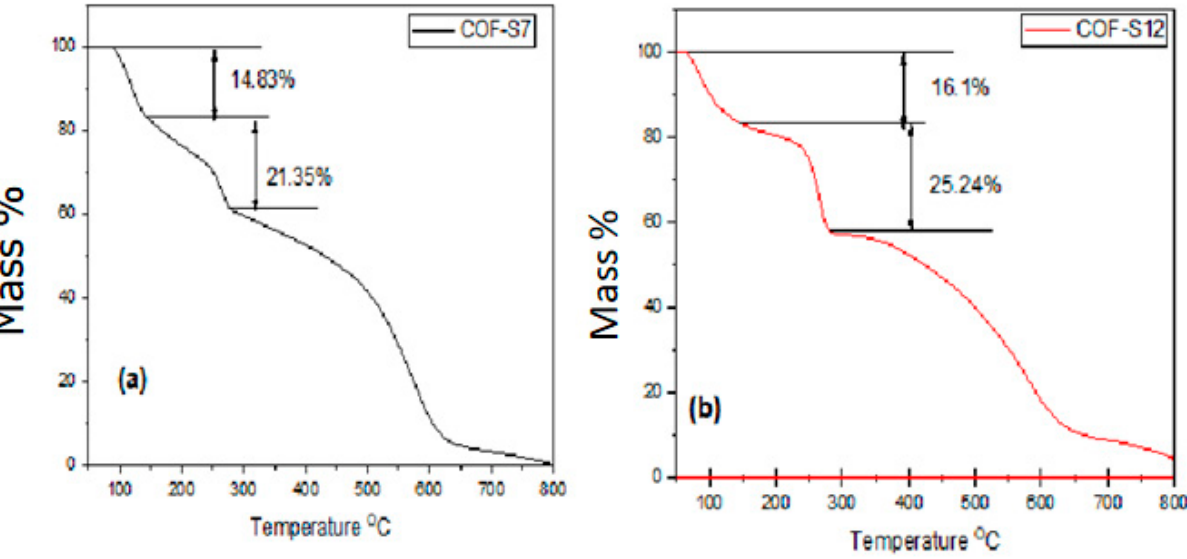
Figure 7. TGA thermogram of ( a ) COF-S7 and ( b ) COF-S12 at heating rate of 10 ◦ C min − 1 . The synthesized compounds obtained displayed the morphological components of the materials via FESEM images in which COF-S7 revealed itself to be even and highly sphere- shaped with a diameter of 100 nm and a rough surface micro-grain porosity crystal-size ar- rangement as shown in Figure 8. This is comparable with the results of [65], who produced a QD-doped COFs@MIP containing 1,3,5-triformylphloroglucinol (TP) and phenylenedi- amine (Pa). Similarly, COF-S12 revealed a nanocrystal porosity with a uniform homo- geneous cubic morphology and diameters of 1 µ m and 100 nm, respectively. The same architecture size was observed in a study [60], in which a SiCOF-5 was produced by condensation by reticulating dianionic hexacoordinate [SiO6] 2 − nodes. Energy-dispersive X-ray (EDX) analysis confirmed the stoichiometric quantity as well as the morphological structure of the components present in the synthesized materials as shown in Figure 9. The elemental constituents (%) displayed atomic peaks that proved the presence of the elements (C, N, O and Si) in percentages, which further confirmed the synthesis of the new COFs. COF-S7 exhibited all of the predicted elements, with 55.98, 13.51, 22.27 and 5.25 in atomic % and 66.65, 7.06, 12.10 and 14.16 in weight % for C, N, O and Si, respectively. Similarly, COF-S12 indicated uniform atomic % and weight % values of 57.25, 12.31, 24.99 and 5.45, and 56.03, 7.68, 13.17 and 23.11,